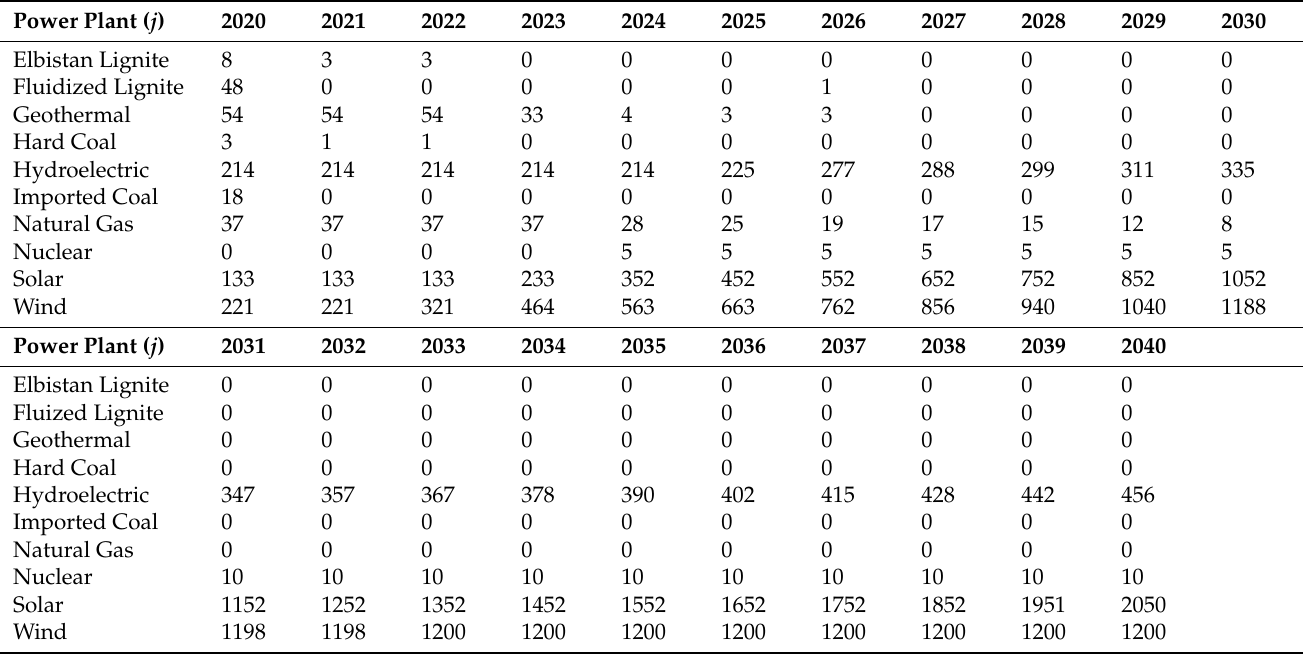
Table 4. Number of Power Plants ( N jt ) for the 2020–2040 Period. Power Plant ( j